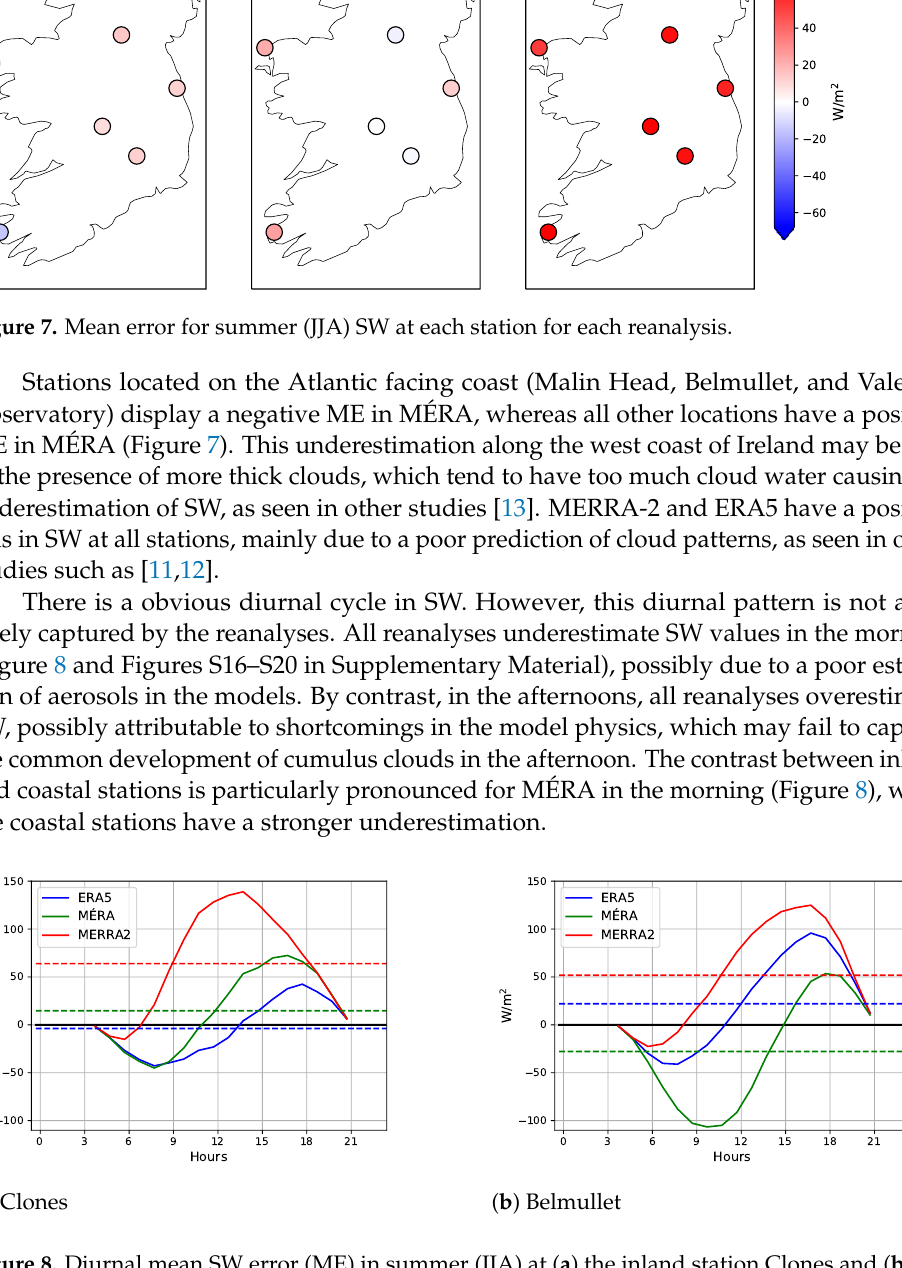
Figure 8. Diurnal mean SW error (ME) in summer (JJA) at ( a ) the inland station Clones and ( b ) the coastal station Belmullet for ERA5 ( blue ), MÉRA ( green ), and MERRA-2 ( red ). The horizontal dashed line represents the overall average seasonal